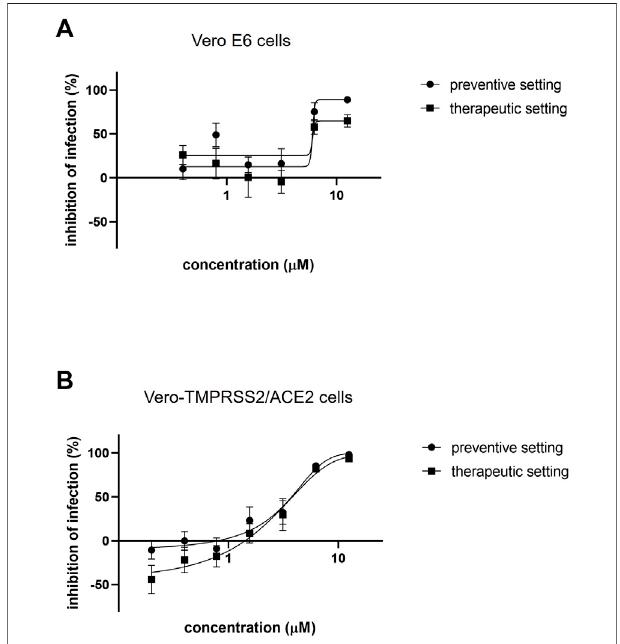
FIGURE 3 | Azelastine is effective against SARS-CoV-2 infection in Vero cell lines. (A) Vero E6 or (B) Vero-TMPRSS2/ACE2 cells were infected with SARS-CoV-2 B.1.177 simultaneously with or 30 min prior to the addition of 0.4 – 12.5 µM of azelastine. After 48 h, RNA was extracted from the cell culturesupernatant and wasquanti fi edbydropletdigitalPCR (A) orqPCR (B) analysis. Graphs show inhibition of infection expressed as viral genome count relative to untreated, virus only control (%) and the mean ± SEM from 5 (A) or 3 (B) biological replicates and 2 (A) or 3 (B) technical repeats.